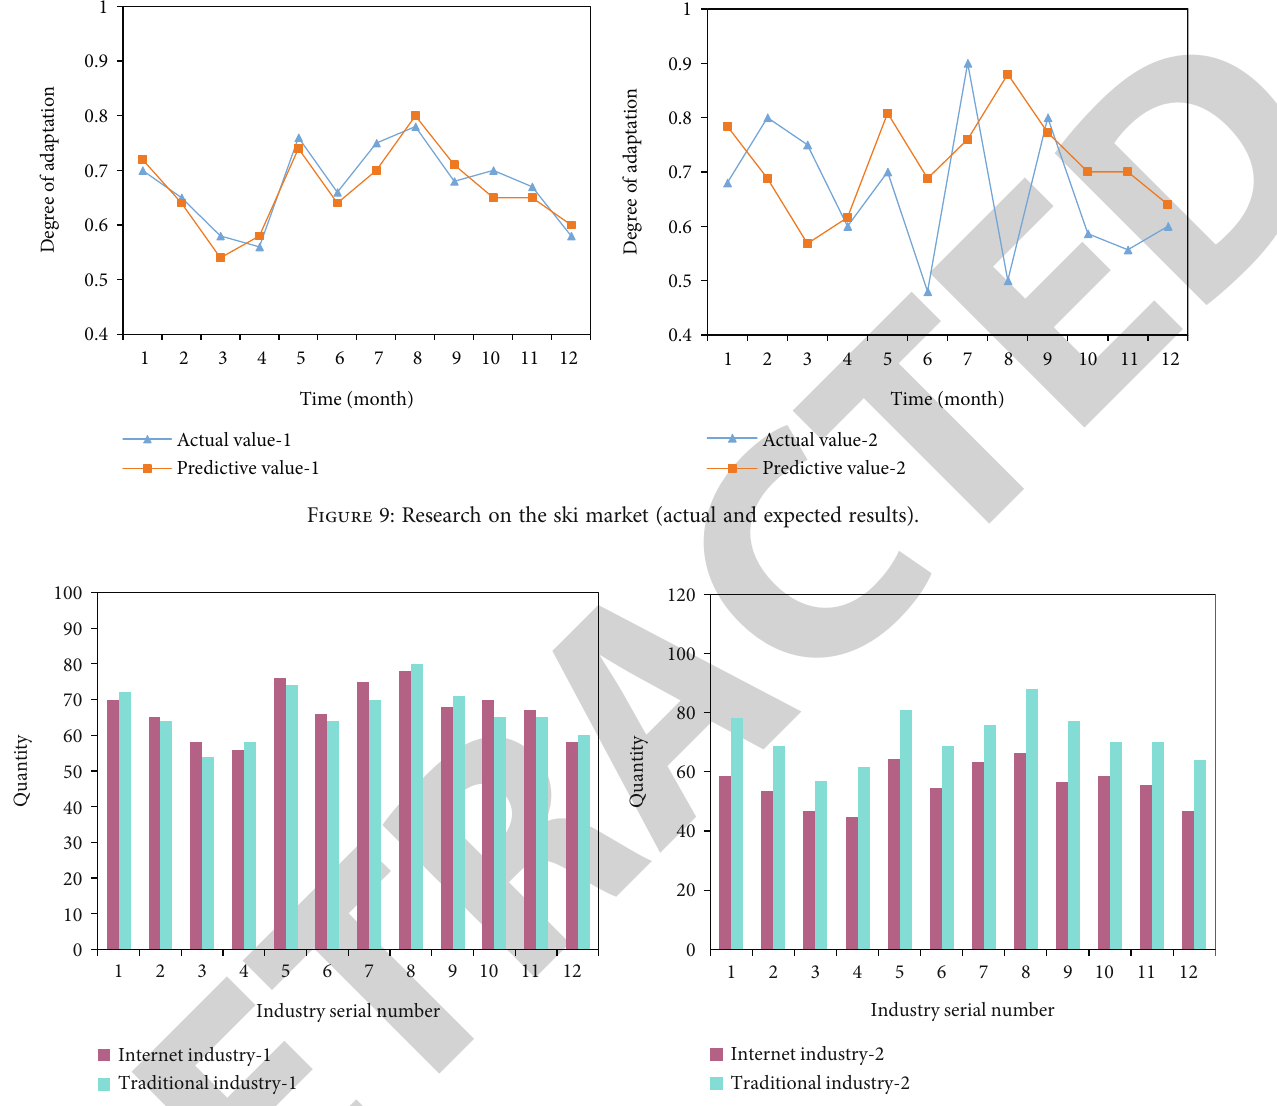
Figure 10: The speci fi c number of cooperation between various industries and the ice and snow tourism